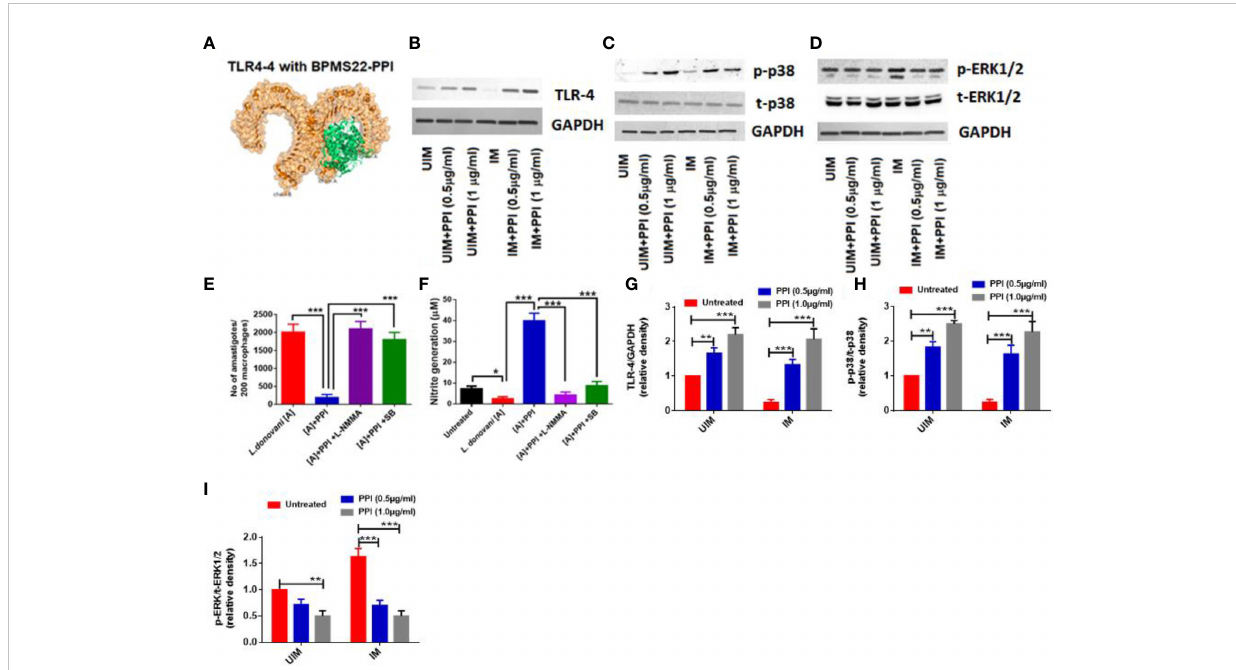
FIGURE 2 Effect of the PPI on TLR-4, p38MAPK, and ERK1/2 expression in L. donovani -infected macrophages. BPMS22 – PPI and TLR4 interaction in silico (A) . BALB/c-derived macrophages were infected with L. donovani promastigotes, followed by treatment with the protein protease inhibitor (PPI). After 30 min of treatment, the protein was extracted and subjected to western blotting to study the expression of TLR4, p-p38MAPK, and p-ERK1/2 (B – D, G – I) . In a separate set of experiments, macrophages were infected with L. donovani . They were pre-treated with a p38 inhibitor (SB203580 at 5 m g/ml) and iNOS inhibitor (L-NMMA at 0.4 mM) for 1 h, followed by the PPI treatment. At 48 h post-treatment, an anti-amastigote study was performed by the Giemsa staining method (E) , and NO generation was performed by Griess assay (F) . Data are expressed as mean ± SD from triplicate experiments. * p < 0.05, ** p < 0.01*** p <